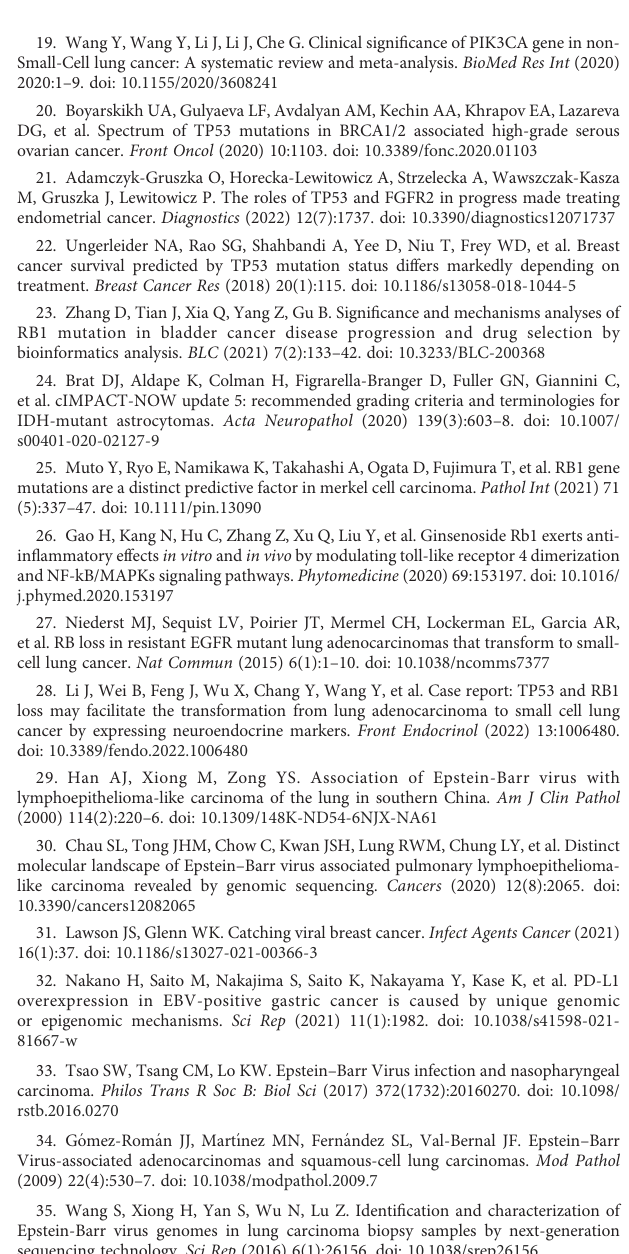
SUPPLEMENTARY FIGURE 5 In fl uence of histological subtypes and stages on high-grade tumors Mutational signatures are shown for lung adenocarcinoma (A) , and early b and advanced-stage (C)